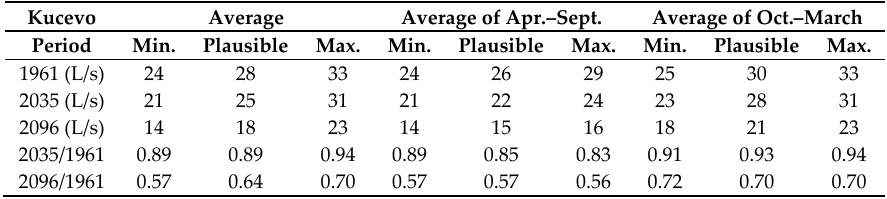
Table 5. Water availability based on average monthly hydrology—worst year of the period, at Mlaka. Kucevo Average Average of Apr.–Sept. Average of